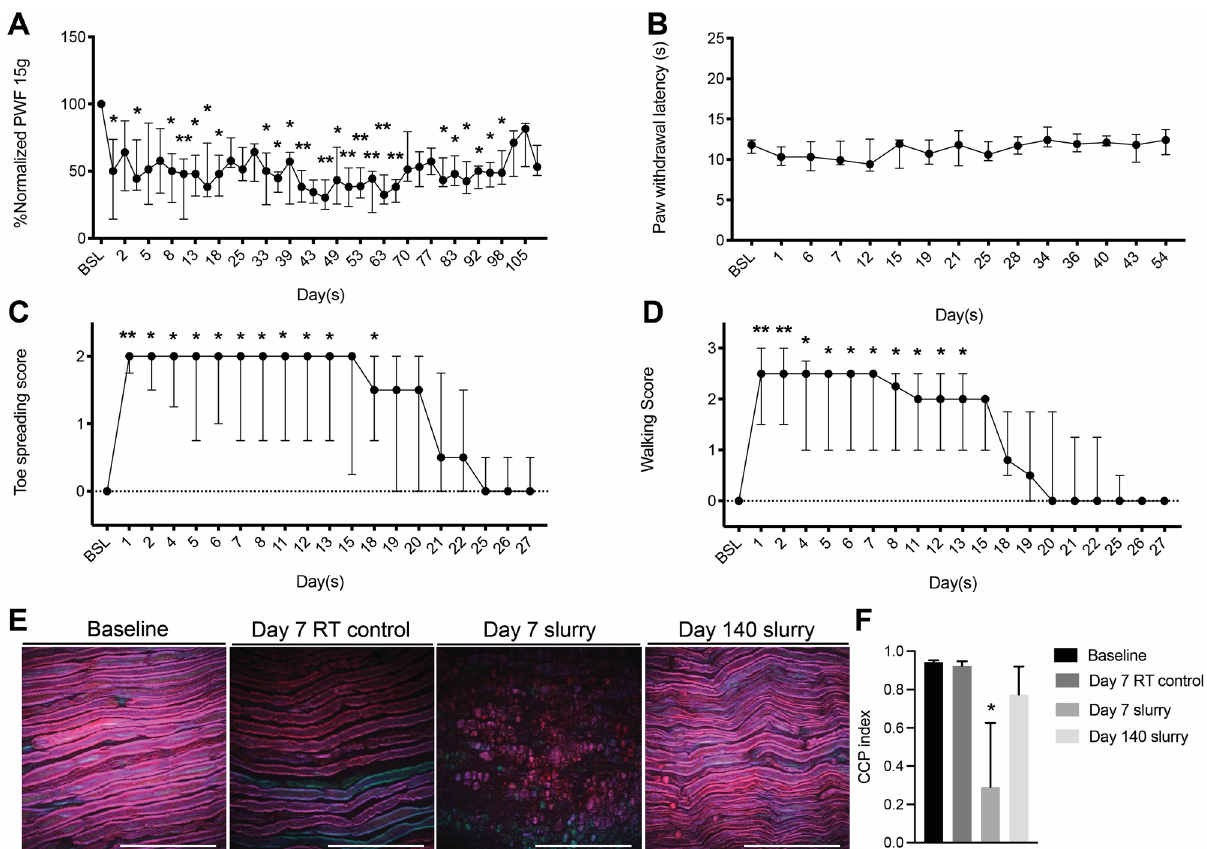
Figure 2. Slurry shows rapid onset reduction in nerve function ( A ) Paw withdrawal frequency in response to stimulation with 15 g VFH force at different time points post slurry injection. ( B ) Effects of slurry injection on paw withdrawal latency in response to heat stimulation in treated hind limbs. ( C ) Toe spread and ( D ) walking scores of hind limbs treated with slurry. Data are presented as median with interquartile range. n = 9; * P < 0.05, ** P < 0.001 compared to baseline values by Friedman test followed by Dunn’s multiple comparisons test. ( E ) CARS microscopy images show myelin and nerve structure in sciatic nerve samples after injection of slurry